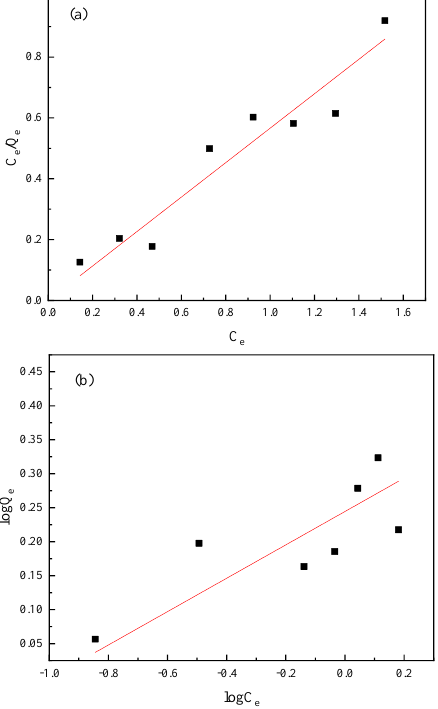
Figure 4. Fitting results of the isotherm equations for thiourea’s adsorption on mica : ( a ) Langmuir isotherm equation and ( b ) Freundlich isotherm equation.